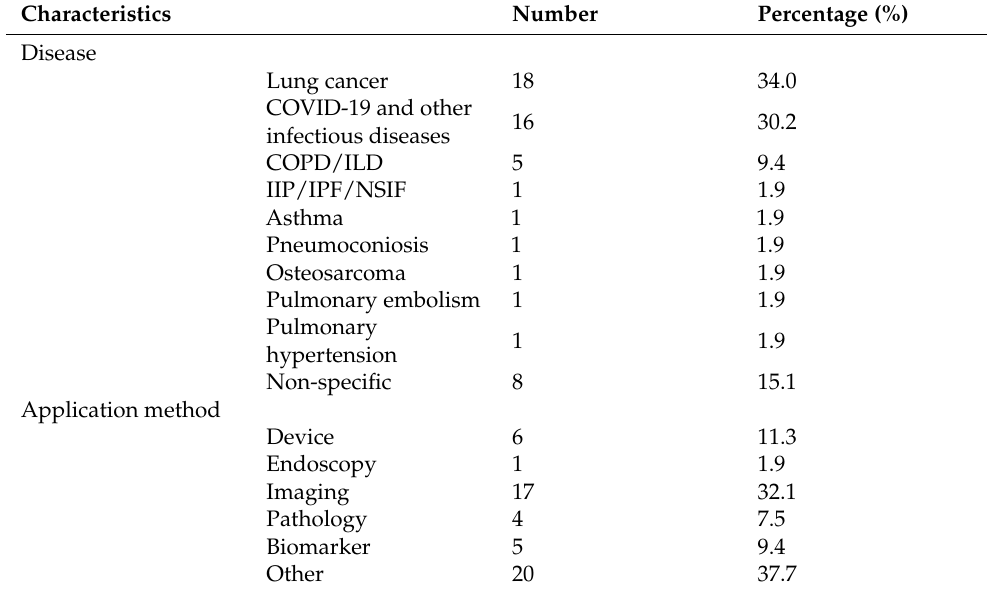
Table 4. Overview of clinical trials in